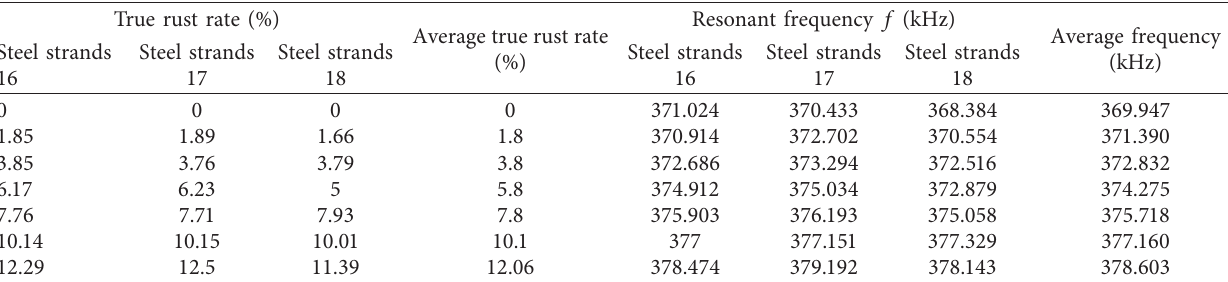
Table 8: Test data of the sixth group of steel